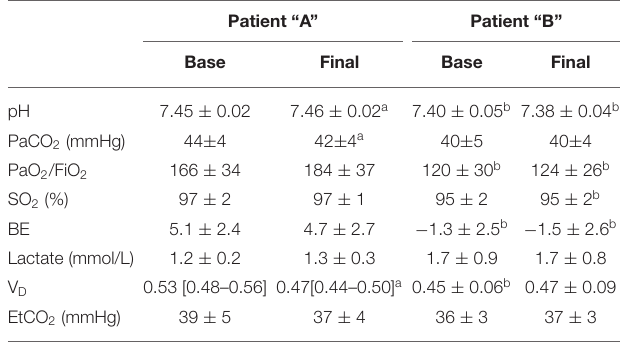
Frontiers in Medicine |